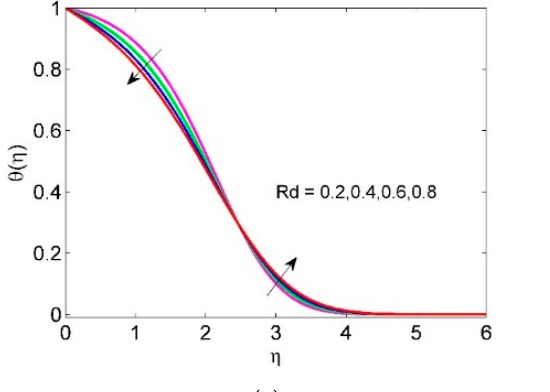
Figure 4. Impacts of M on 𝑓 ′ (𝜂) , 𝜃(𝜂) and 𝜙(𝜂) . Figure 5a observed that as thermal radiation Rd rises, the temperature profile initially declines, but after moving far from the surface, the temperature profile exhibits the opposite trend. Because thermal radiation more is dominant than thermal conduction. The temperature profile rises due to an increase in Eckert number as depicted in Figure 5b. Physically, an increase in Ec converts kinetic energy into internal energy by work that is conducted against viscous fluid stress, which rises the temperature field.